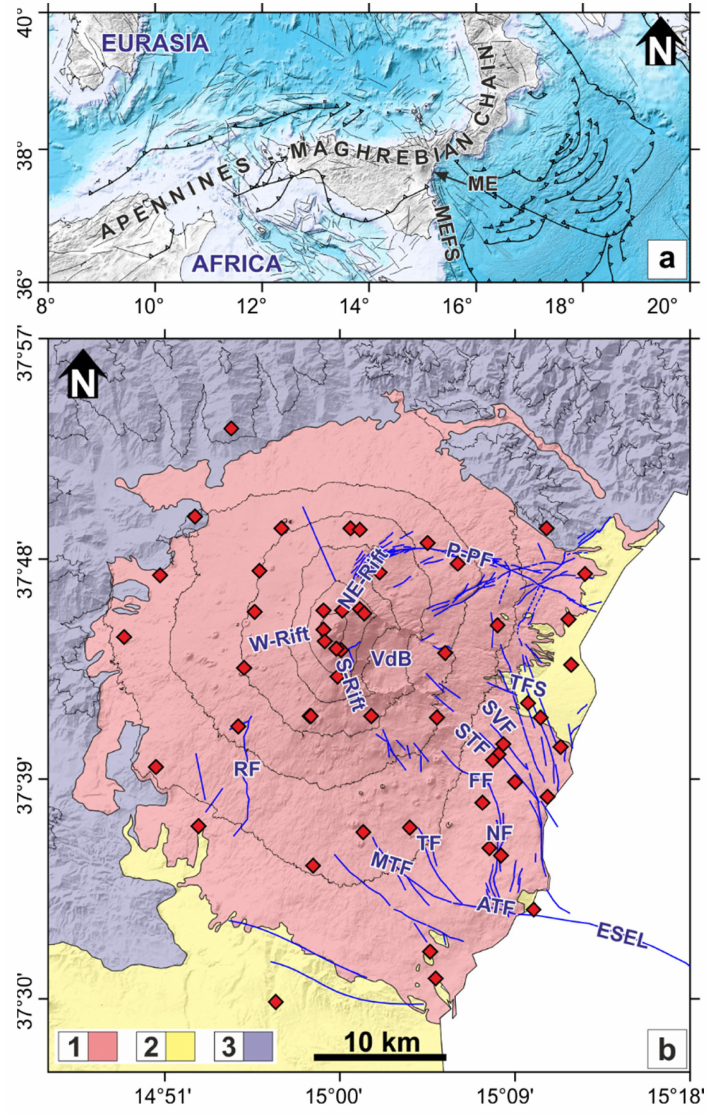
Figure 1. ( a ) Tectonic map of central Mediterranean. Abbreviations are: ME, Mt. Etna; MEFS, Malta Escarpment fault system. ( b ) Simplified geologic map of Mt. Etna. Legend: (1) volcanic rocks; (2) Early Quaternary clays; (3) Pre-Quaternary sedimentary rocks. Continuous GNSS stations are reported as red diamonds. Abbreviations are as follows: NE-Rift, North-East Rift; W-Rift, Western Rift; SE-Rift, South-East Rift; P-PF, Provenzana-Pernicana fault; TFS, Timpe fault system; SVF, Santa Venerina fault; STF, Santa Tecla fault; FF, Fiandaca fault; NF, Nizzeti fault system; TF, Trecastagni fault; MTF, Mascalucia-Tremestieri fault; ATF, Aci Trezza fault; RF, Ragalna fault; ESEL, ESE